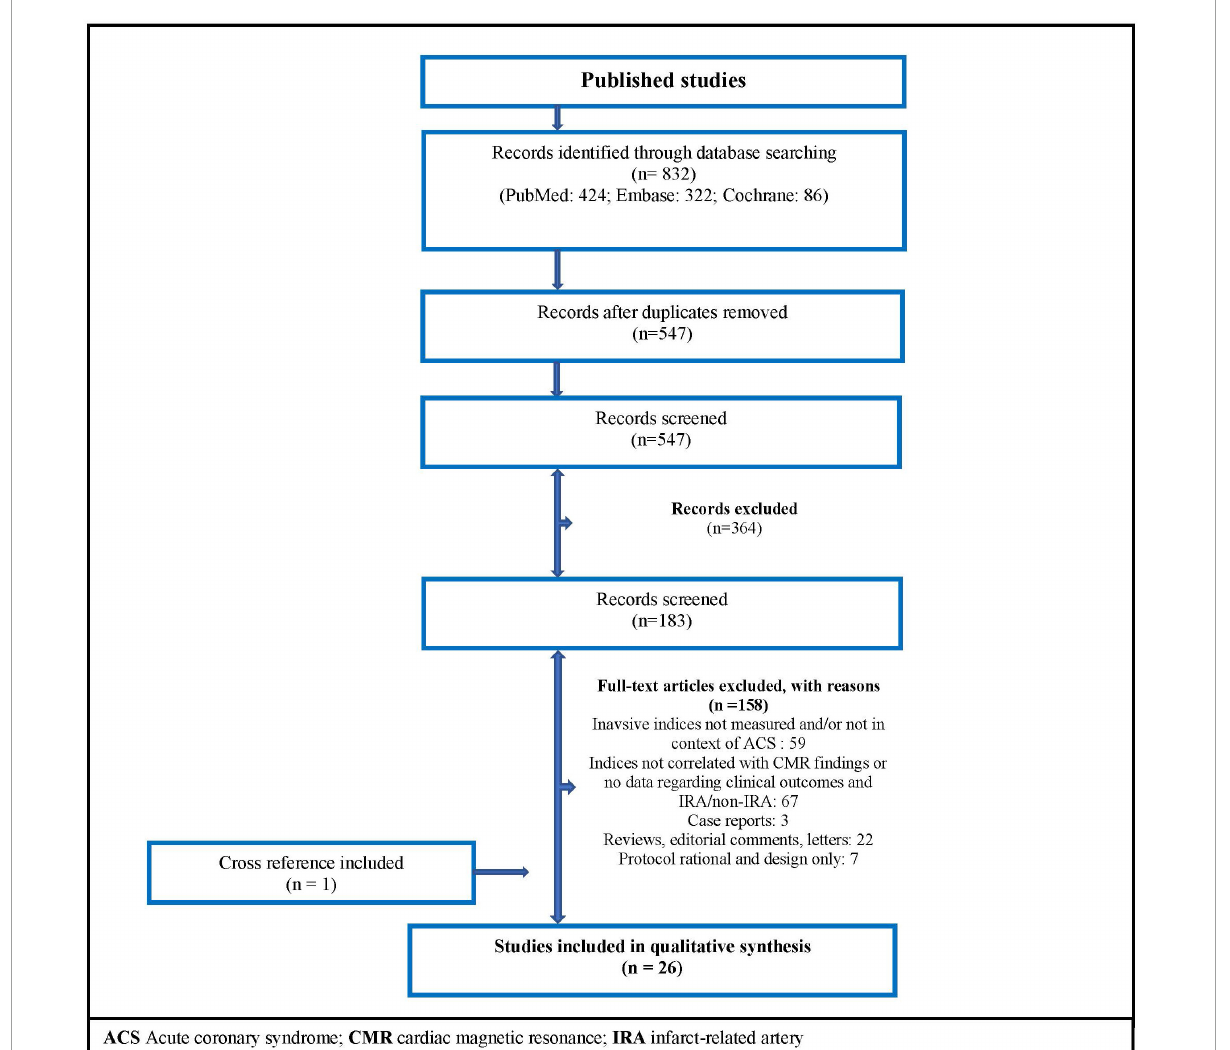
FIGURE3 Flow diagram of the search strategy. ACS, acute coronary syndrome; CMR, cardiac magnetic resonance; IRA, infarct-related